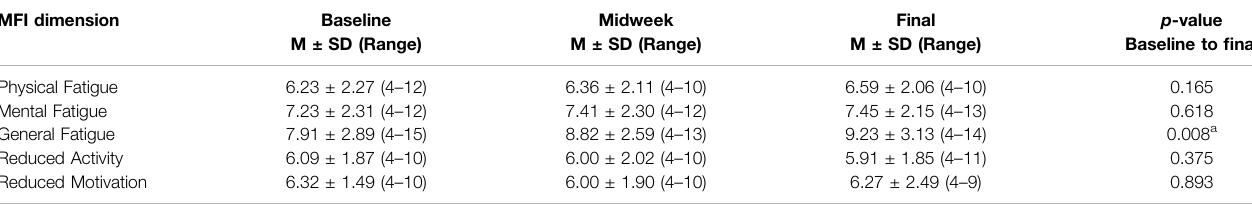
a Indicates signi fi cance following Bonferroni-Holm correction for multiple comparisons.